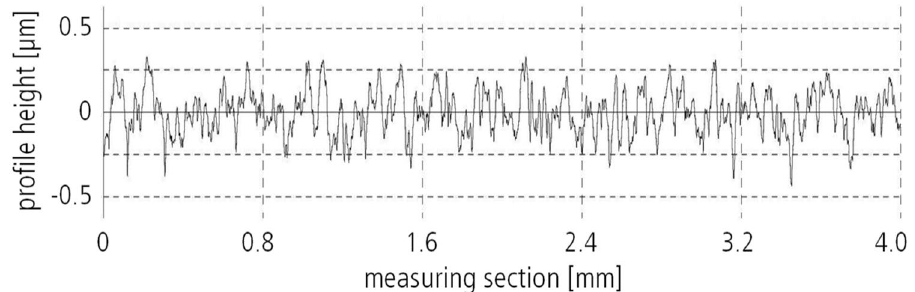
Fig. 3 Profilometry for a sam- ple sandblasted with a working distance of 1.0 cm, blasting pressure of 6 bar, 90° blasting angle and a forward speed of 3.5